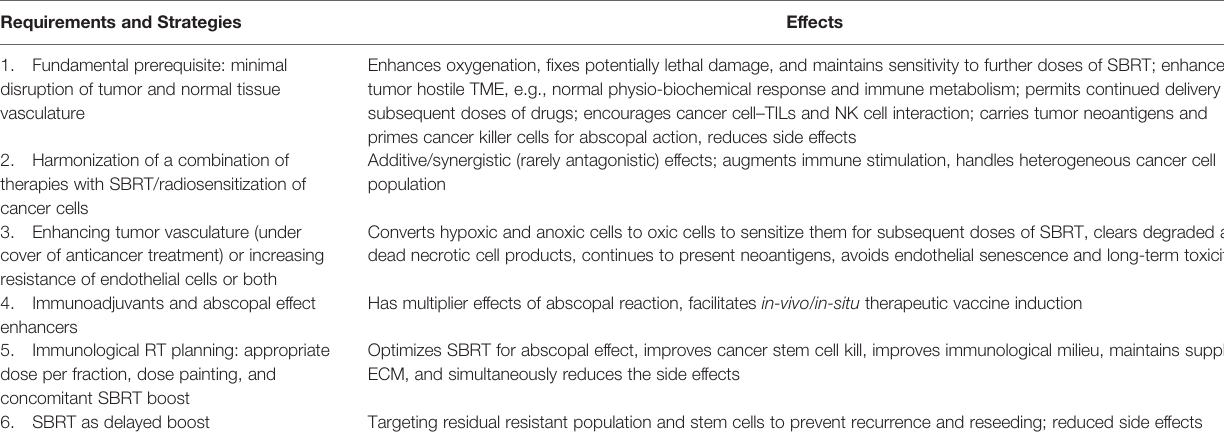
TABLE 1 | Proposed fundamental and supporting requirements to facilitate augmented abscopal